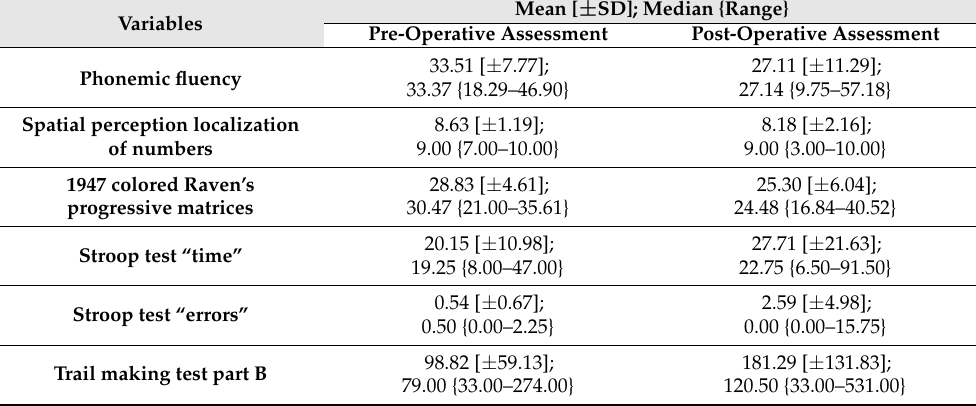
Table A3. Changes of neuropsychological variables.